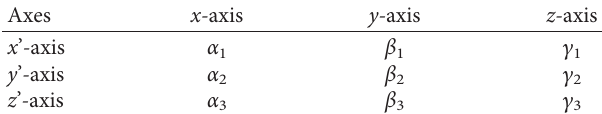
Table 2: The angles between axes of two coordinate systems. Axes x-